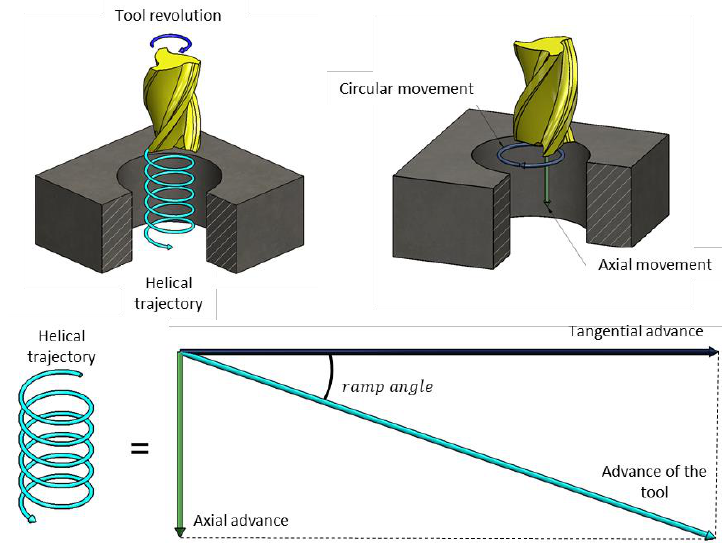
Figure 1. Kinetic decomposition of helical movement.